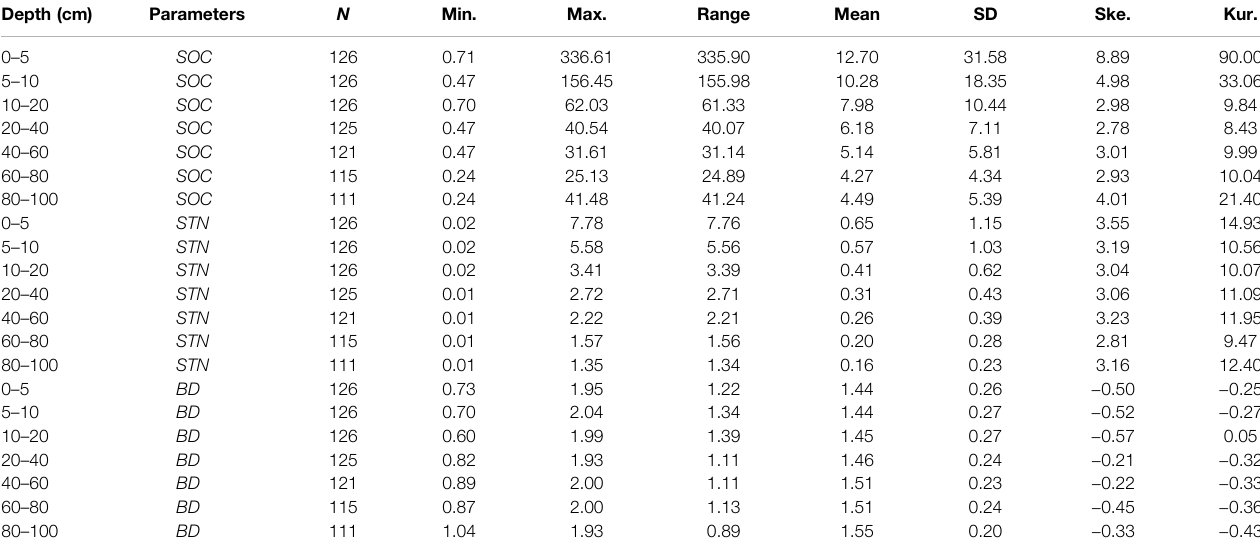
TABLE 1 | Descriptive statistics for the soil organic carbon ( SOC ) concentration (g kg − 1 ), soil total nitrogen ( STN ) concentration (g kg − 1 ), and bulk density ( BD ) (g cm − 3 ) across the 100 cm pro fi le. a Depth (cm) Parameters N Min. Max. Range Mean SD Ske. Kur.